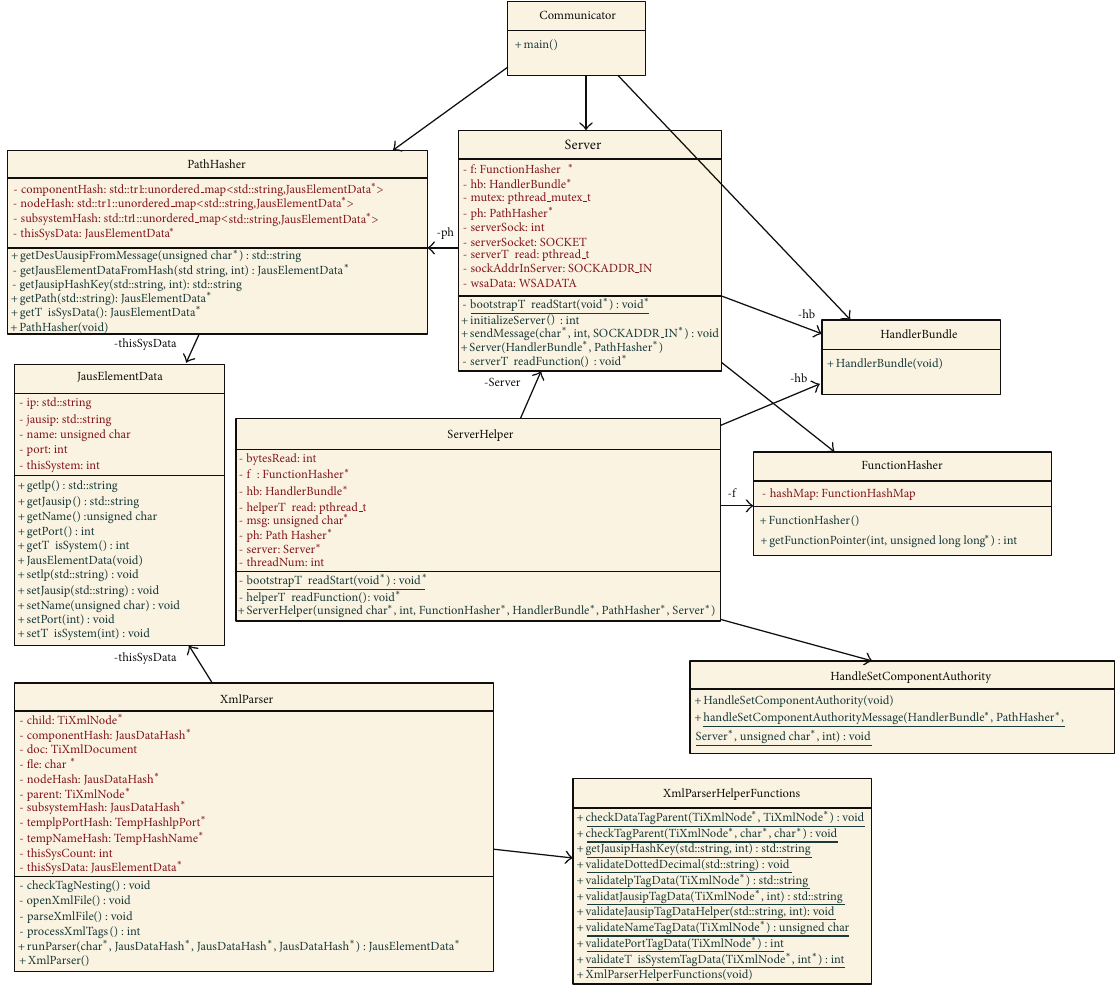
Figure 8: Class Diagram for